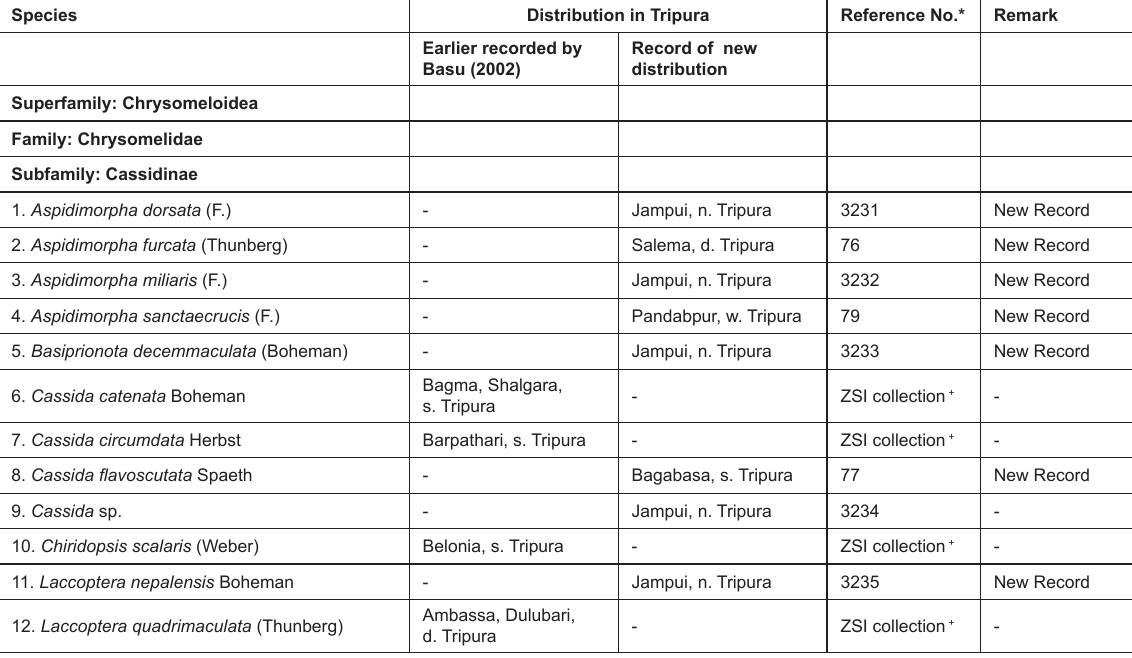
Table 2. Records of Cassidinae beetles of Tripura